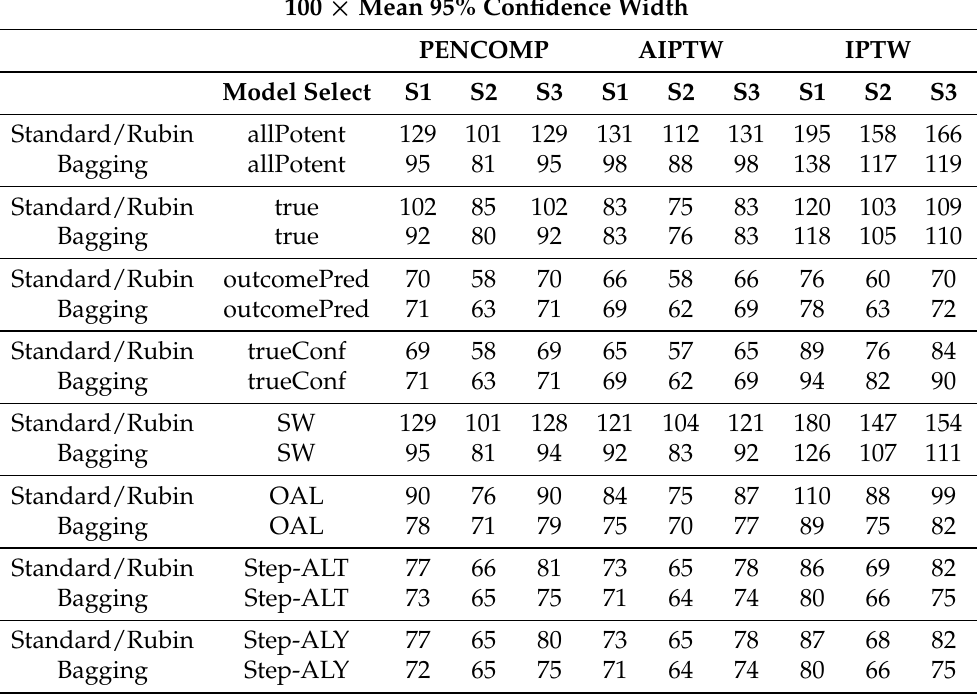
Table A2. 100 × mean 95% confidence interval width with sample size of 200. The treatment effects η = 2. S1, S2, and S3 denote scenario 1, 2, and 3,